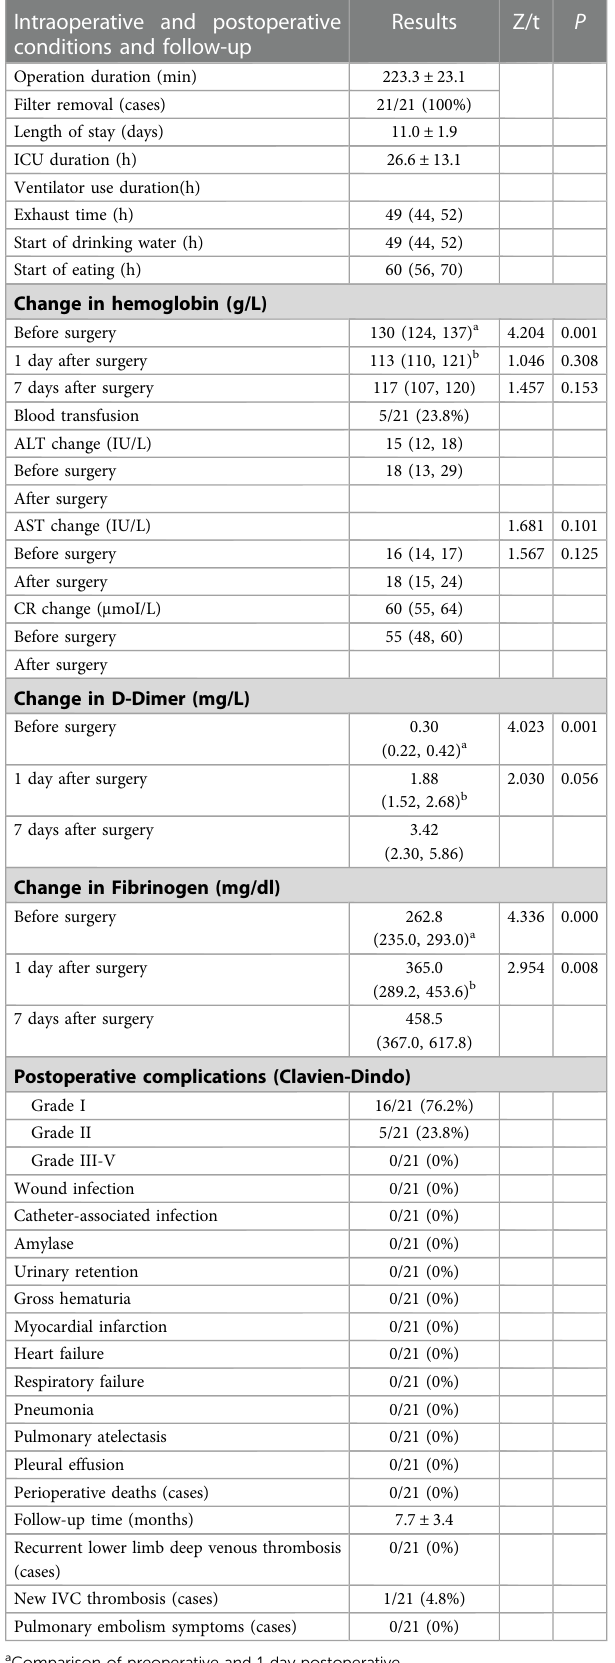
TABLE 3 Intraoperative and postoperative conditions and